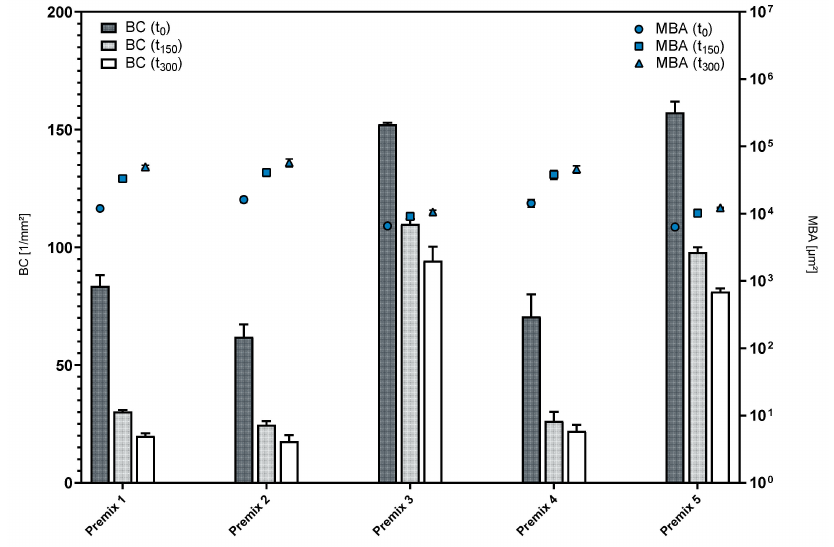
Figure 5. Structure of foamed premixes over time; mean ± SD, n =